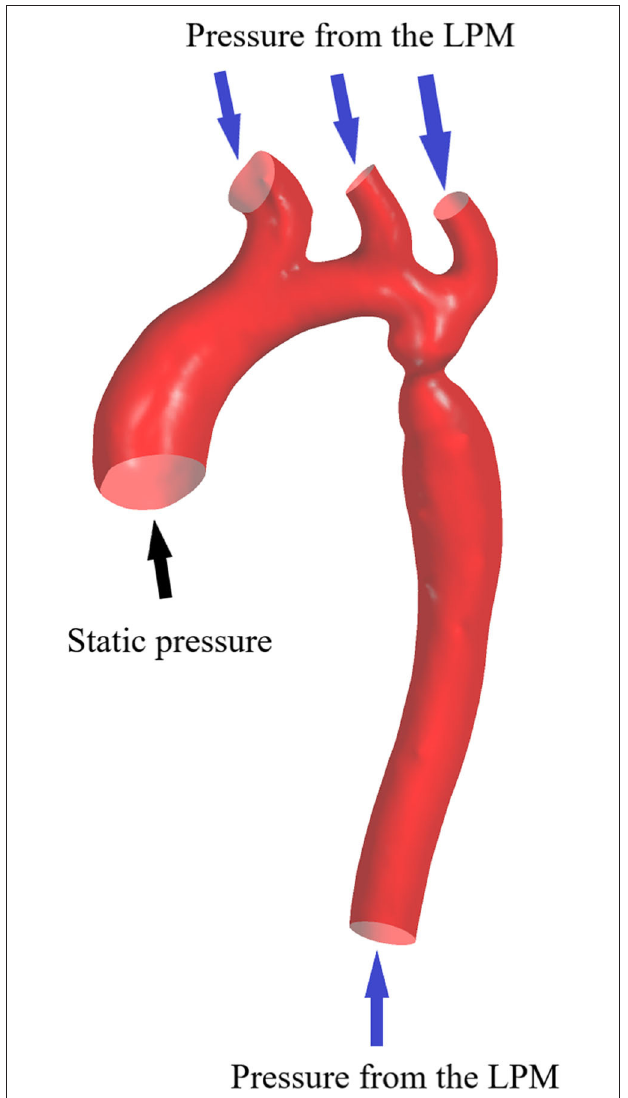
FIGURE 1 | Boundary conditions. Geometry of the aorta with one inlet and four outlet boundaries.